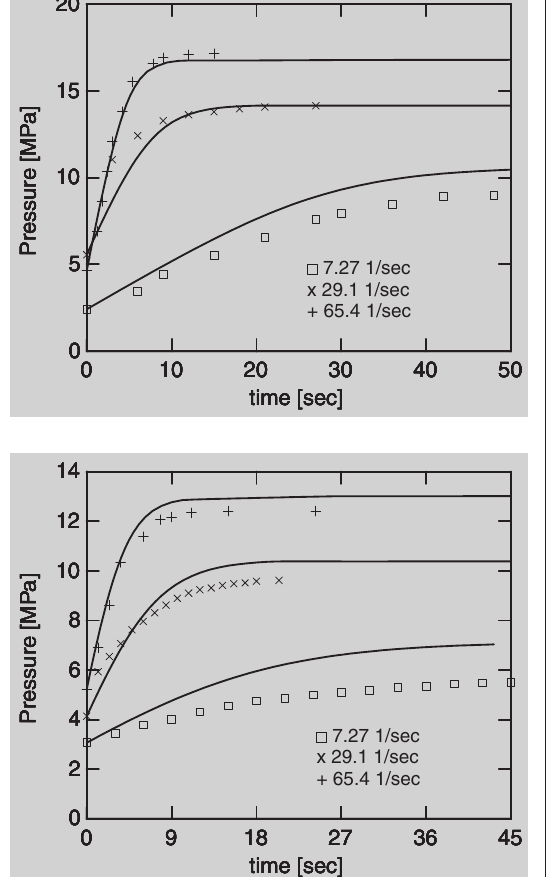
Figure 5 (left above): Rising pressure transient for NR compound in 10:1 die at 110˚C Figure 6 (right above): Rising pressure transient for NR compound in 30:1 die at 110˚C Figure 7 (left below): Rising pressure transient for PVMQ compound in 10:1 die at 120˚C Figure 8 (right below): Rising pressure transient for PVMQ compound in 30:1 die at